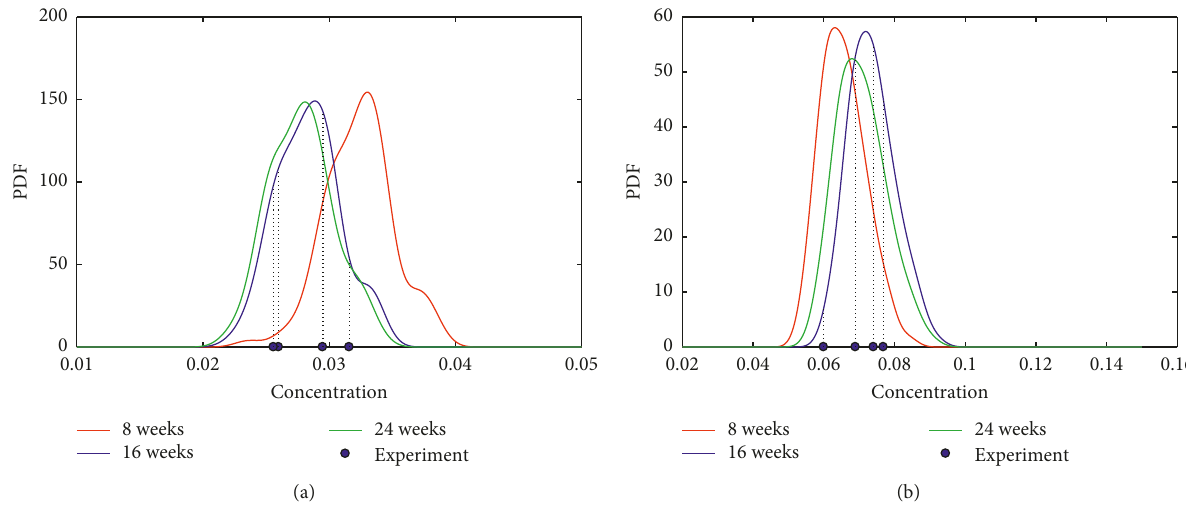
Figure 15: PDFs of the concentration of (a) gypsum and (b) ettringite, obtained by solving the SKE-SCR with 13 random variables. Table 3: CDFs of experimentally obtained concentrations of the corrosion products at different times.